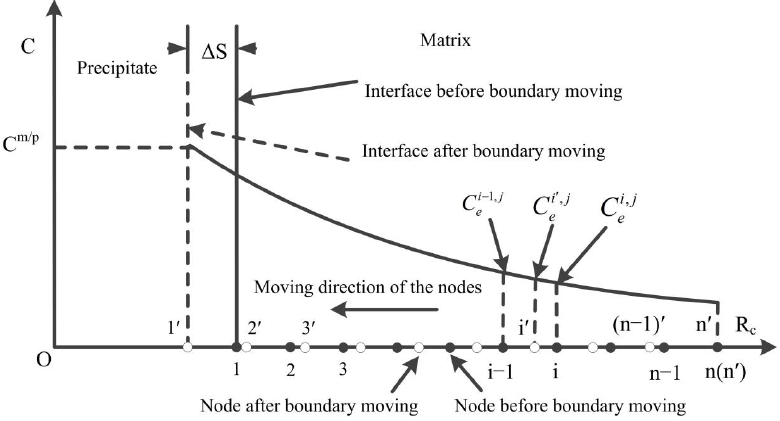
Figure 2. Re-meshing of the nodes after interfacial movement and the calculation of concentration.